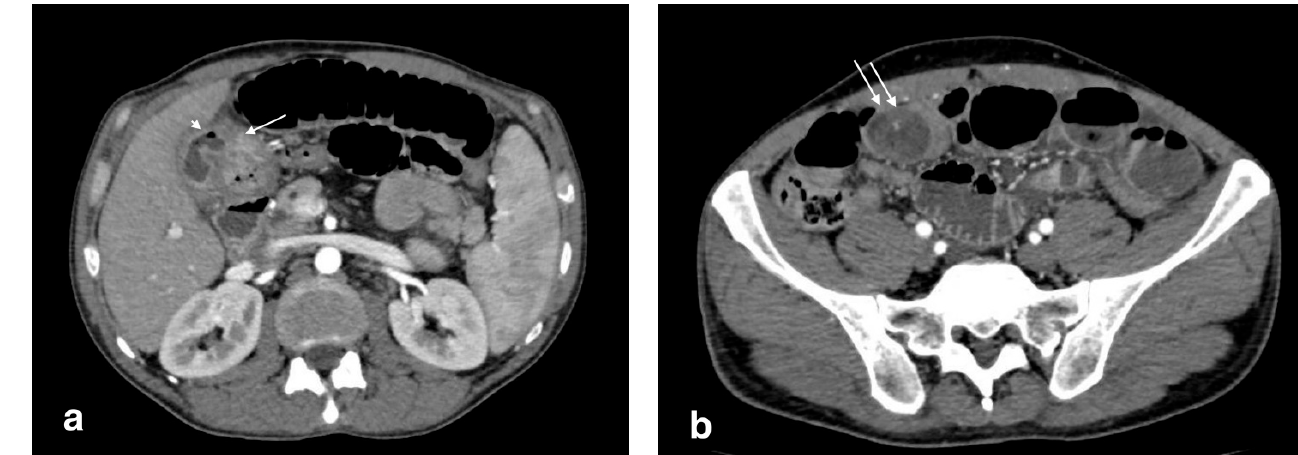
tended posteriorly to the right hepatic lobe (arrows).